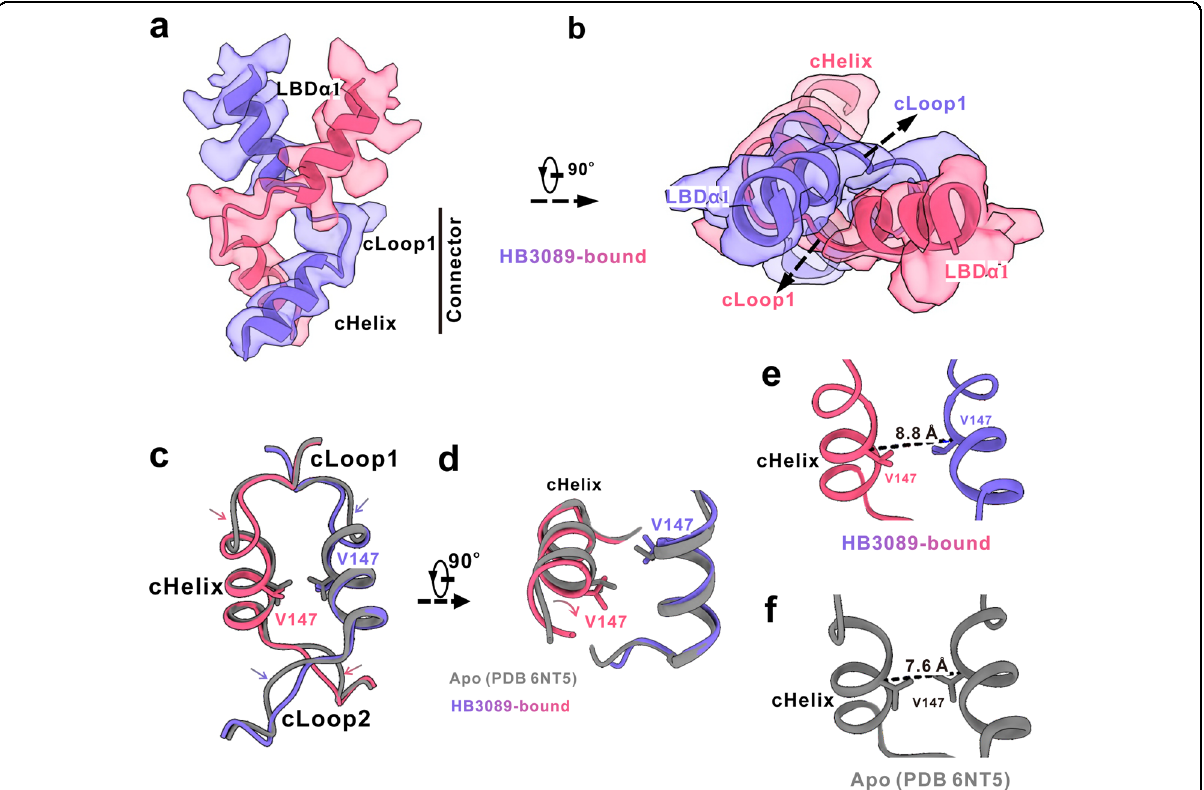
Fig. 3 The conformation change of the connector induced by HB3089 binding. Side ( a ) and top ( b ) views of the connector from HB3089-bound STING, showing the two monomers of the connector and the LBD α 1 form the right-handed crossover. For clarify, the cLoop2 of the connector is not shown. The map and the model are displayed in transparent surface and ribbon, respectively, and are colored as in Fig. 2b. c , d Structural comparison of the connectors between the HB3089-bound STING (red and purple) and the apo STING (grey), showing the helices and the loops of the connector from the HB3089-bound STING revolved (curved arrows) and moved downwards (arrows), respectively. The residues of Val147 are indicated by side chain showing. e , f The atomic models of the connector helices from the HB3089-bound STING ( e , red and purple) and the apo STING ( f , grey), showing the inter-C α distance between residues Val147 at the